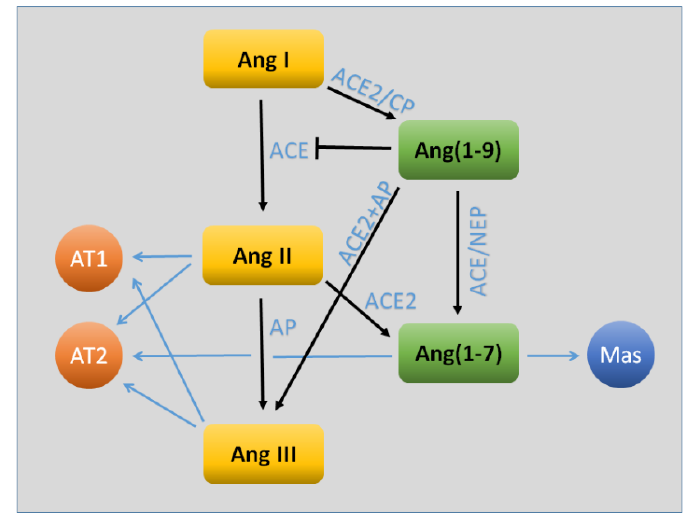
Figure 1. Key components of the angiotensin (Ang) system relevant to the blood–brain barrier. The traditional arm of the system (shown in yellow) consists of the sequential processing of Ang I, Ang II, and Ang III. The latter two act upon the AT1 receptor to cause a number of physiological actions, including (for the most part) vasoconstriction, increased oxidative stress, and inflammation. The AT2 receptor may contribute as well to oxidative and inflammatory signaling, but may oppose vasoconstriction. In recent years, evidence has been found for a parallel arm (shown in green) that largely opposes the traditional actions of Ang II / Ang III. The primary e ff ector of this system is Ang(1–7), which acts through the Mas receptor. Both Ang(1–9) and Ang(1–7) may also act through AT2R. Abbreviations: ACE, angiotensin-converting enzyme; ACE2, angiotensin-converting enzyme 2; AP, aminopeptidase; CP, carboxypeptidase; NEP, neutral endopeptidase.